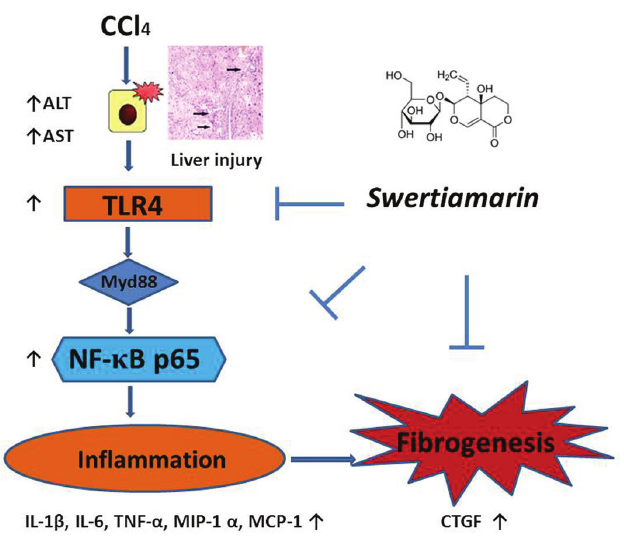
FIGURE 6 - Schematic diagram shows protective signaling of swertiamarin. The ↑ symbol indicates activation or induction, and symbol indicates inhibition or ⊣